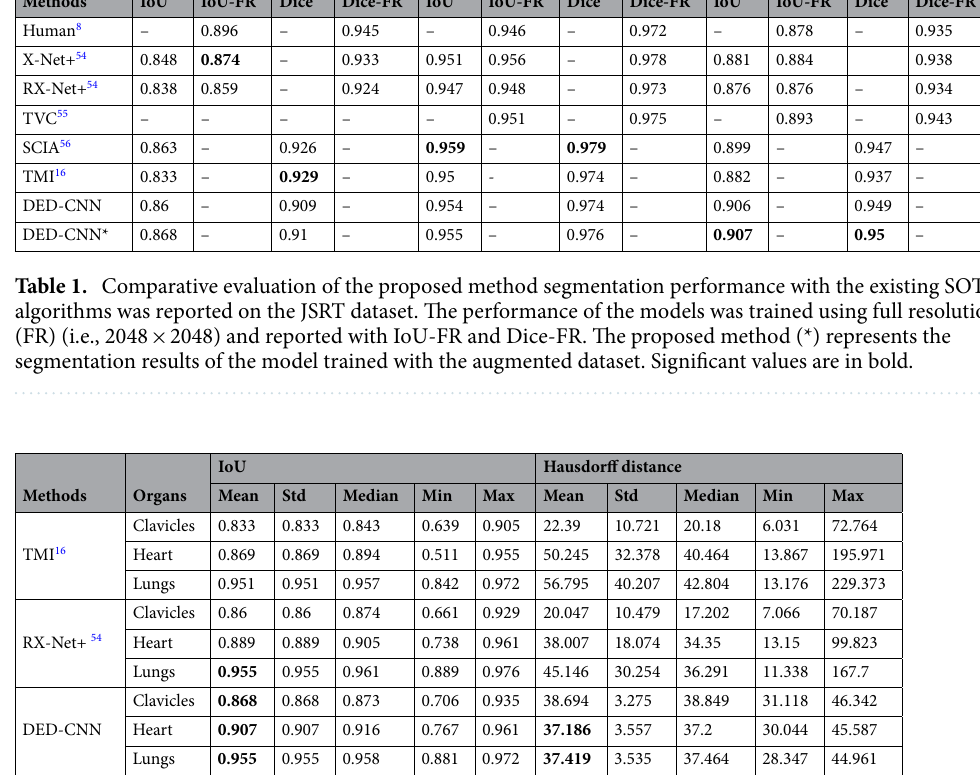
Table 2. An overview of the results based on the IoU and the Hausdorff distance for each architecture and three organs, which include the clavicles, heart, and lungs. The bolded scores are the best-performing networks on the JSRT dataset according to each column’s